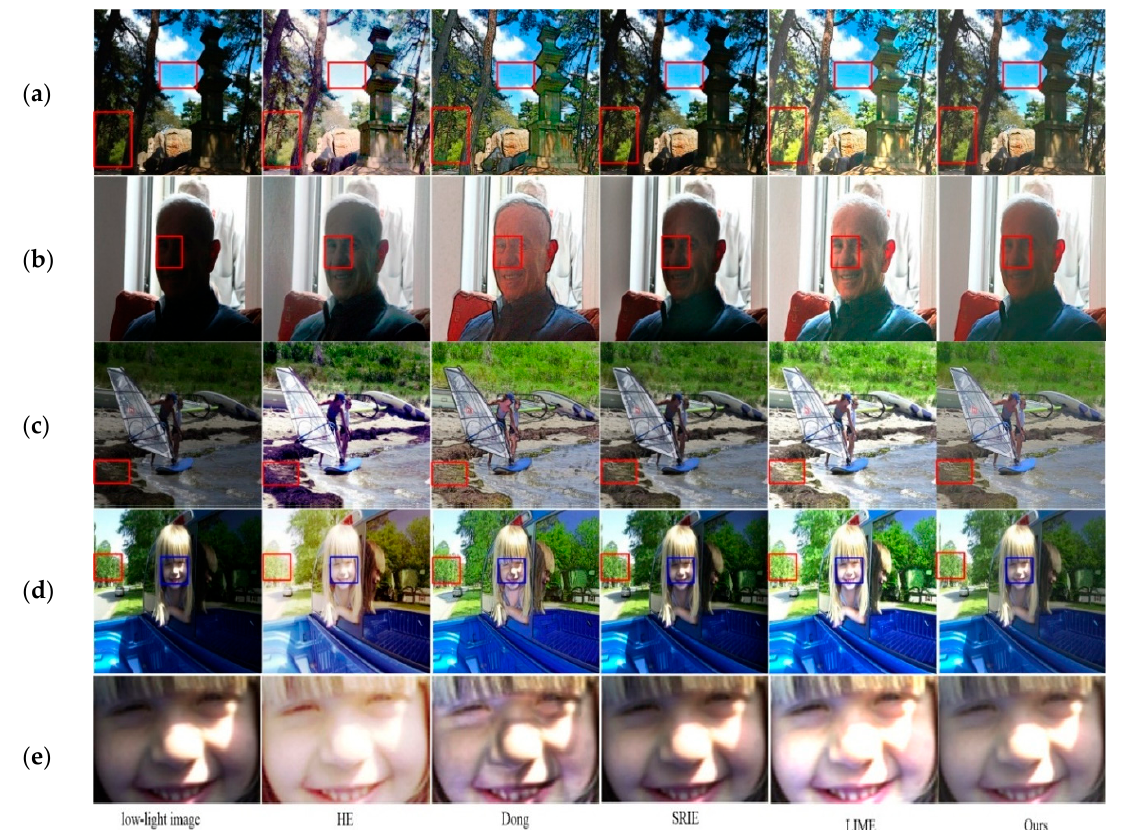
Figure 9. The subjective visual comparison of different algorithms for real low-light images. ( a ) the imae from DICM, ( b ) The image from VV dataset, ( c ) The image from NASA dataset, ( d ) The image from NASA dataset, ( e ) the result of partial enlargement of ( c